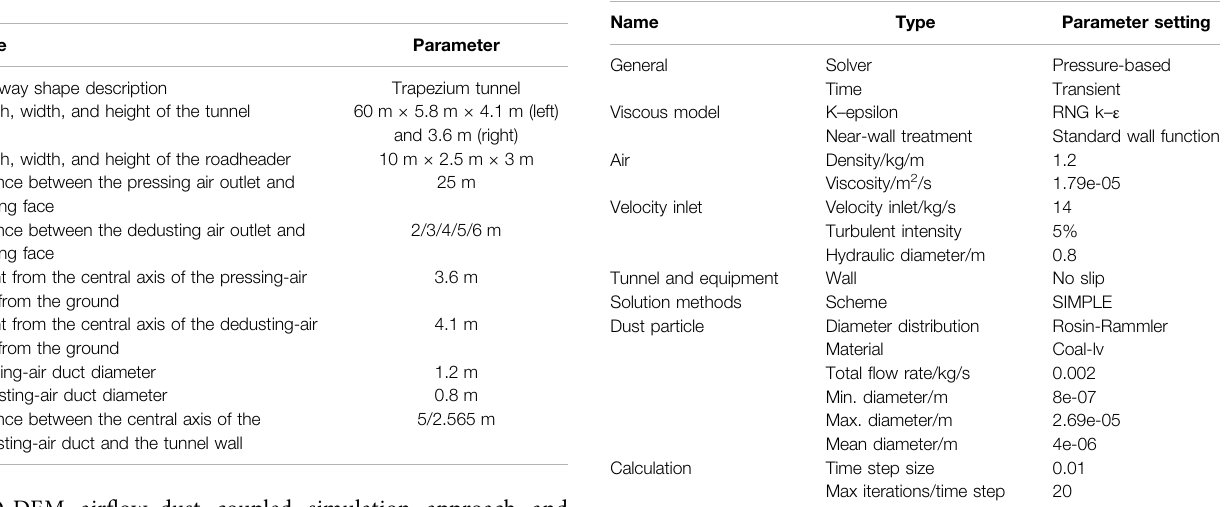
TABLE 2 | Information on boundary conditions in numerical